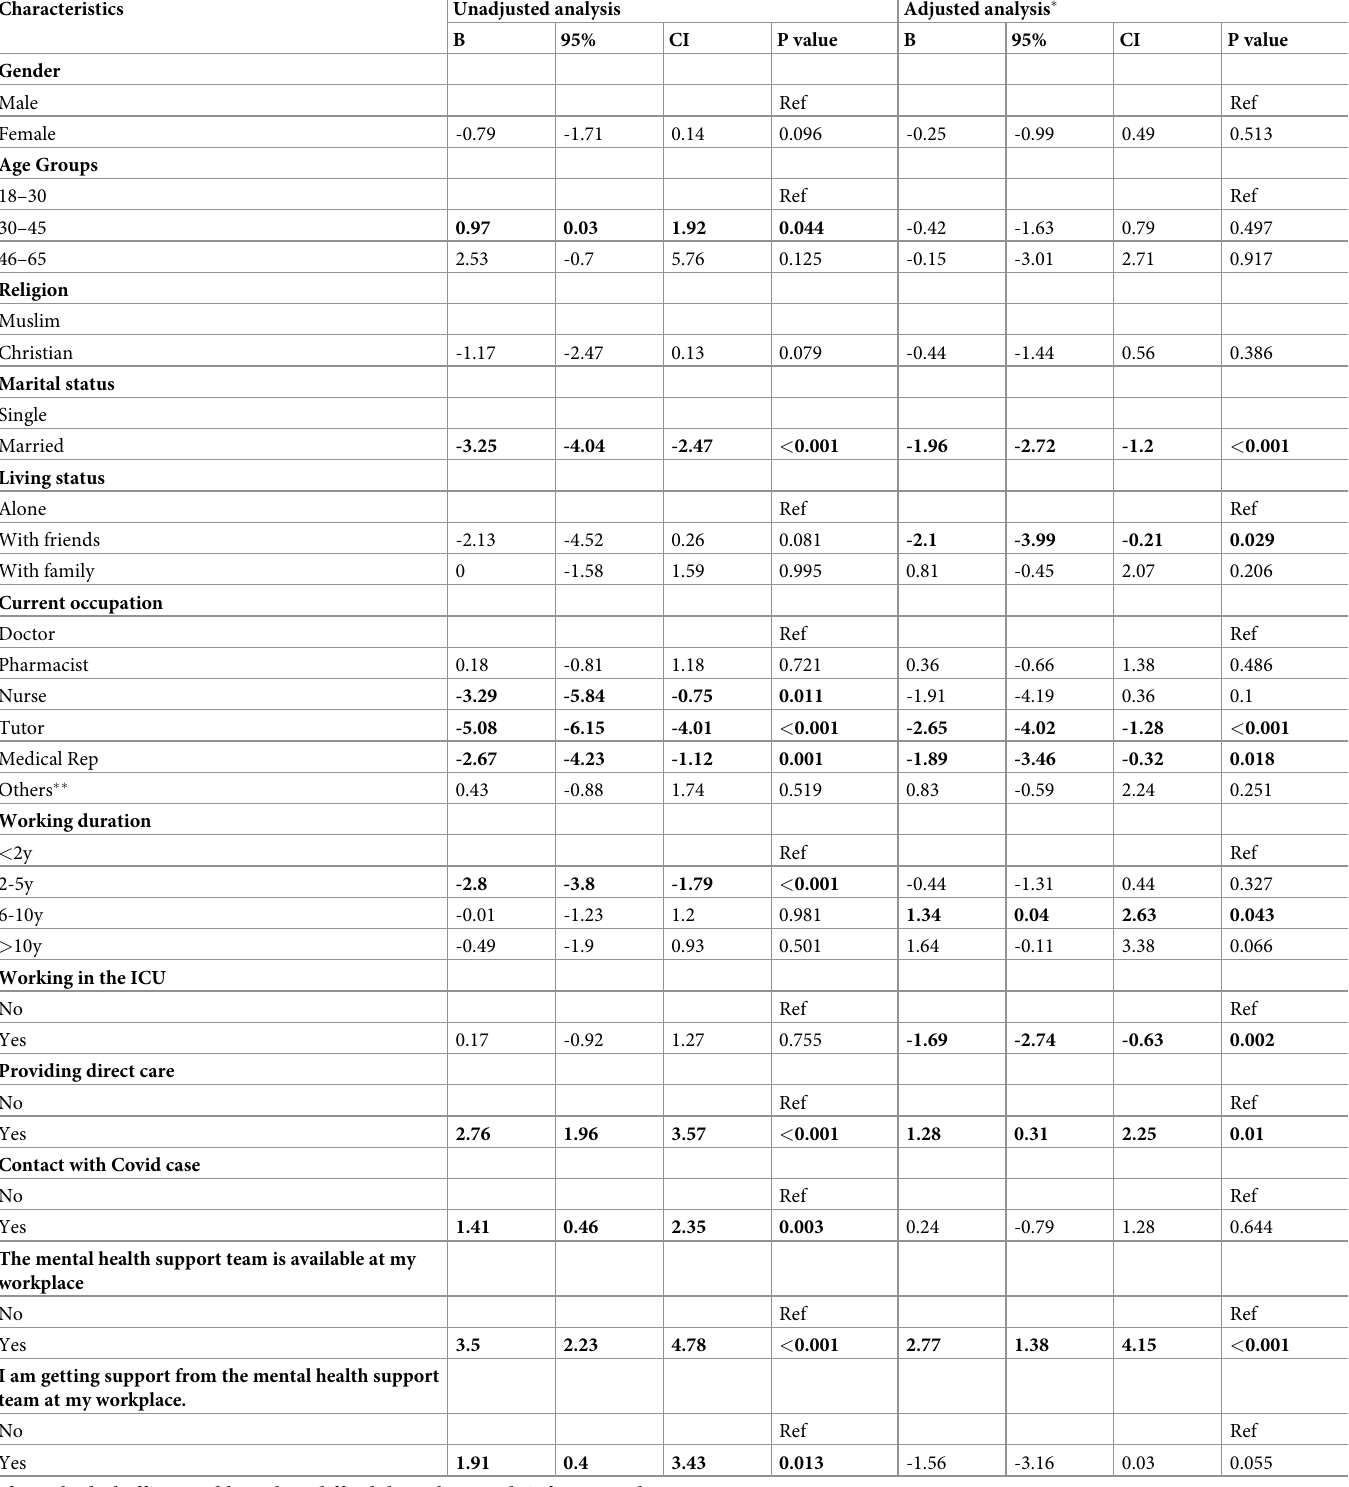
Table 5. General linear model explaining factors associated with attitude towards interprofessional teamwork among study participants.